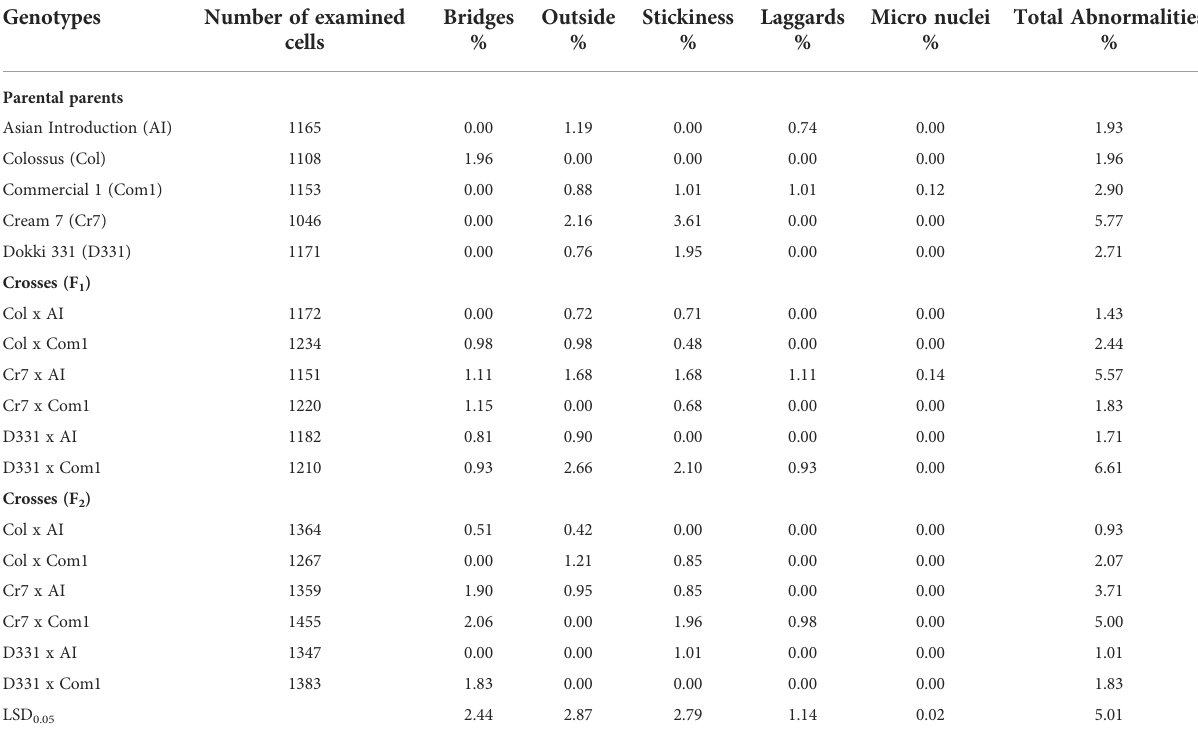
TABLE 8 Proportions of total mitotic abnormalities derived from the root tips of six crosses in F 1 and F 2 produced from crossing between fi ve parental genotypes; Cream 7 cv. ‘ Cr7 ’ , Colossus cv. ‘ Col ’ , and Dokki 331 cv. ‘ D331 ’ genotypes as female parents and Asian Introduction ‘ AI ’ and Commercial 1 ‘ Com1 ’ genotypes as male